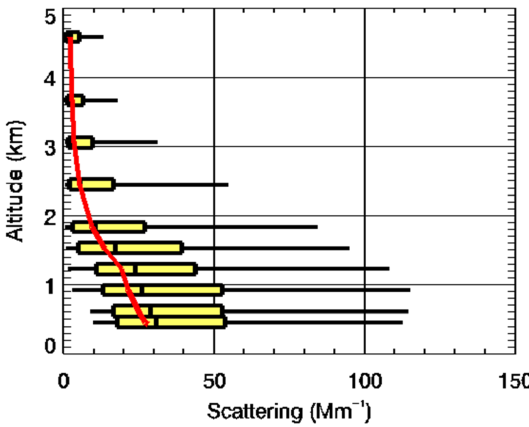
Fig. 13. Cumulative box/whiskers plot of AAO aerosol light scattering profile data adjusted to ambient RH. Individual segment average scattering data were adjusted using the median γ value at each altitude from Fig. 12 and the segment average RH. Red line represents the median dry values from Fig. 8(a).